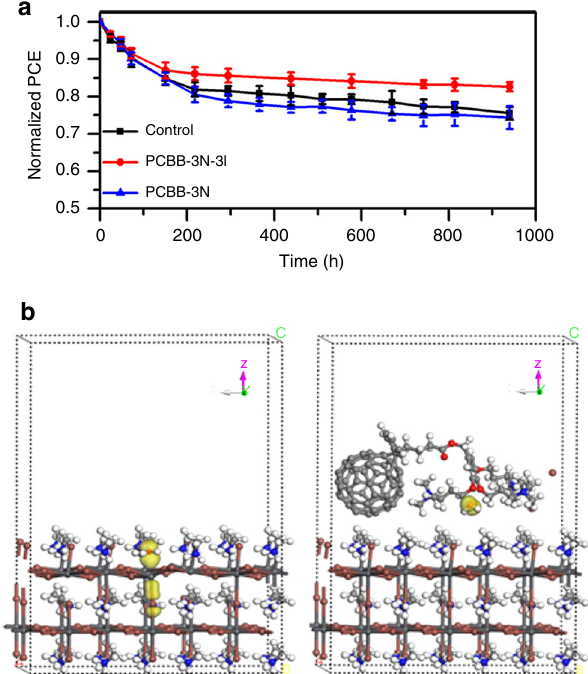
Fig. 5 Device stability of pero-SCs. a Normalized PCE of devices with a structure of ITO/PTAA/MAPbI 3 /PCBM/C 60 /BCP/Cu with and without PCBB-3N-3I/PCBB-3N treatment on MAPbI 3 as a function of storage time in ambient condition with 40 – 50% RH. The error bars are SD in PCE of fi ve devices for each structure. b DFT calculation of interaction between p - orbital of O 2 − of adsorbed H 2 O and p -orbital of Pb 2 + of MAPbI 3 before and after PCBB-3N-3I